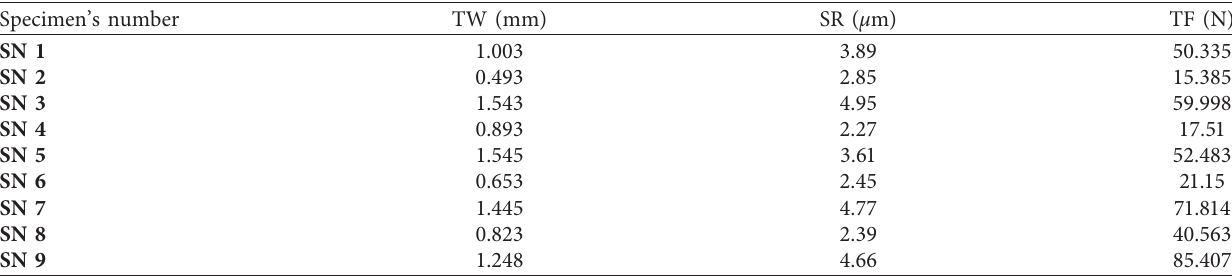
Table 3: Stir casting process parameters and its levels.